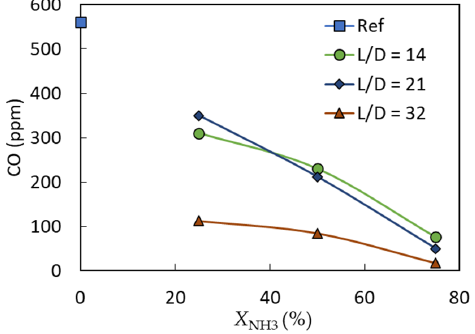
Figure 6. CO emission for ϕ = 1.1 as function of ammonia fractions at different mixing length ratios.